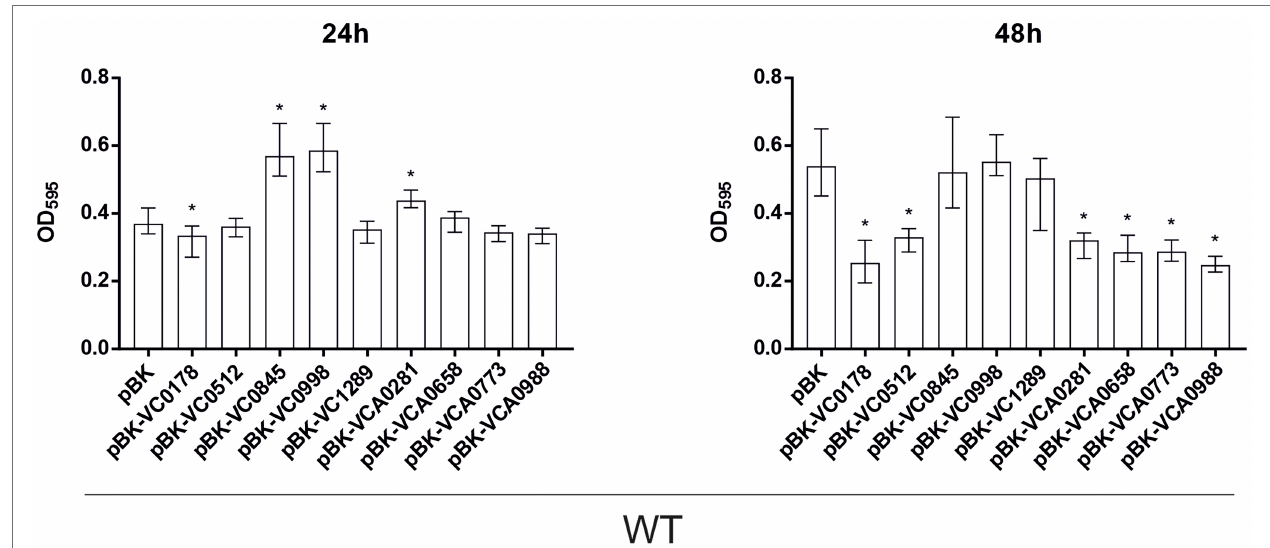
FIGURE 2 | Constitutive ibr gene (over)-expression strains show an altered static biofilm formation compared to wild type (WT) with empty vector. Biofilms of WT carrying empty vector (pBK) and WT with expression plasmids of respective ibr genes, as indicated, were quantified after 24 and 48 h. The biofilm formation capacity was assayed under static conditions by crystal violet staining and subsequent determination of the OD 595 . Shown are the medians from at least 16 independent measurements. The error bars indicate the interquartile range (IQR). An asterisk indicates a significant difference to WT pBK (* p < 0.001 Kruskal–Wallis test followed by post hoc Dunn’s multiple